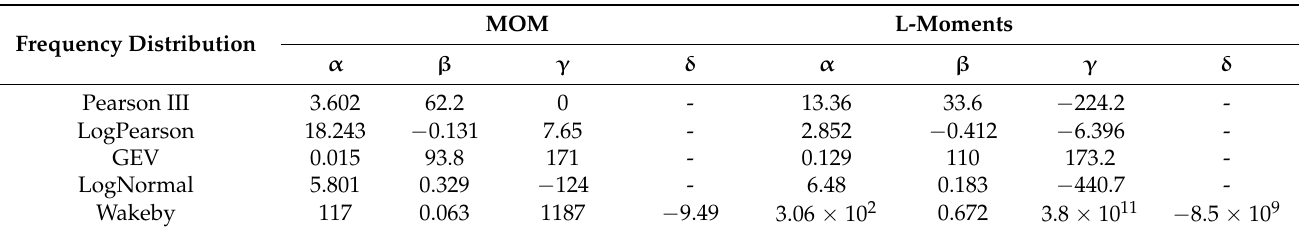
Table 2. Parameter estimates by the MOM and L-moments.